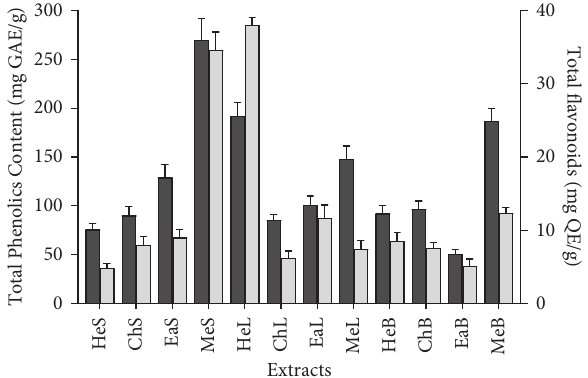
Figure 1: Total phenolics and flavonoids contents of extracts of E. japonica . HeS, hexane extract of seeds; ChS, chloroform extract of seeds; EaS, ethyl acetate extract of seeds; MeS, methanol extract of seeds; HeL, hexane extract of leaves; ChL, chloroform extract of leaves; EaL, ethyl acetate extract of leaves; MeL, methanol extract of leaves; HeB, hexane extract of bark; ChB, chloroform extract of bark; EaB, ethyl acetate extract of bark; MeB, methanol extract of